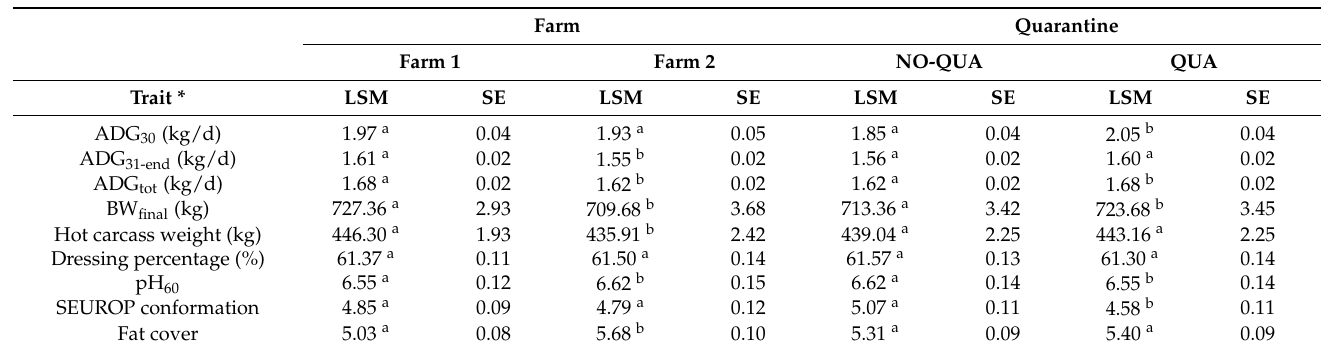
Table 2. Least squares means (LSM) and standard error (SE) of growth and post-mortem performances 1 of Charolaise young bulls ( n = 575) for farm and quarantine status 2 effects.